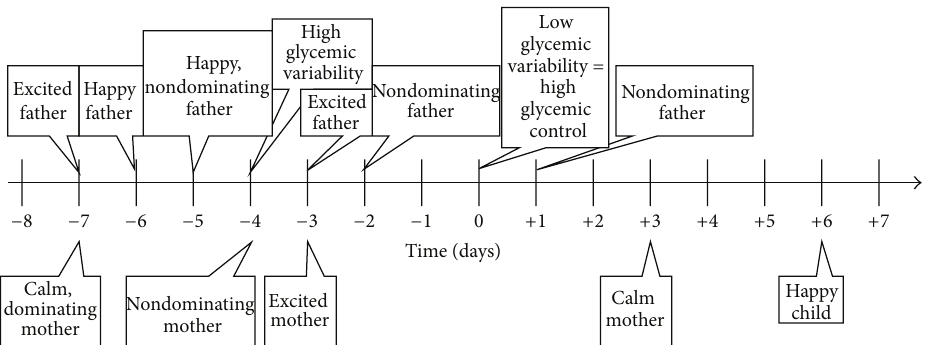
Figure 1: Timeline displaying effects correlating with high glycemic control. The graph depicts a psychosomatic cycle in which various emotional states of all involved family members influence glycemic variability of the adolescent patient and vice versa.